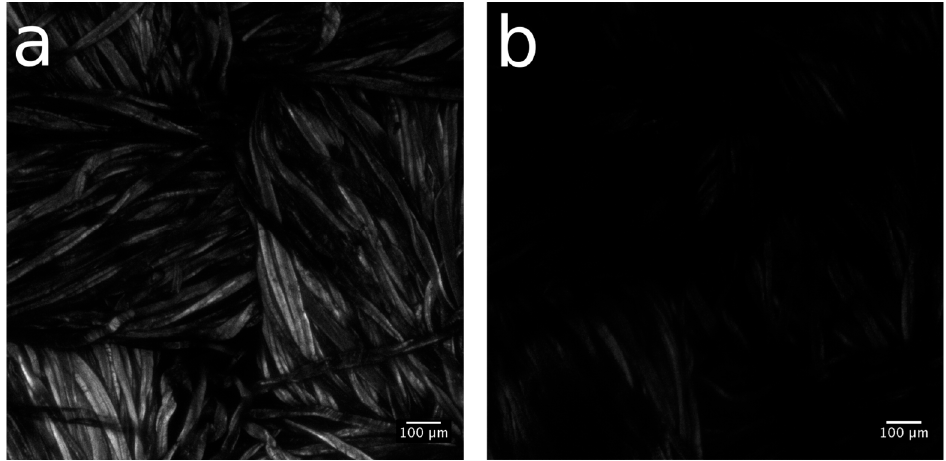
Figure 6. Confocal microscopy image of ( a ) Cotton-NBB80h and ( b ) Cotton-NBB80h C14 click samples after CPM treatment.